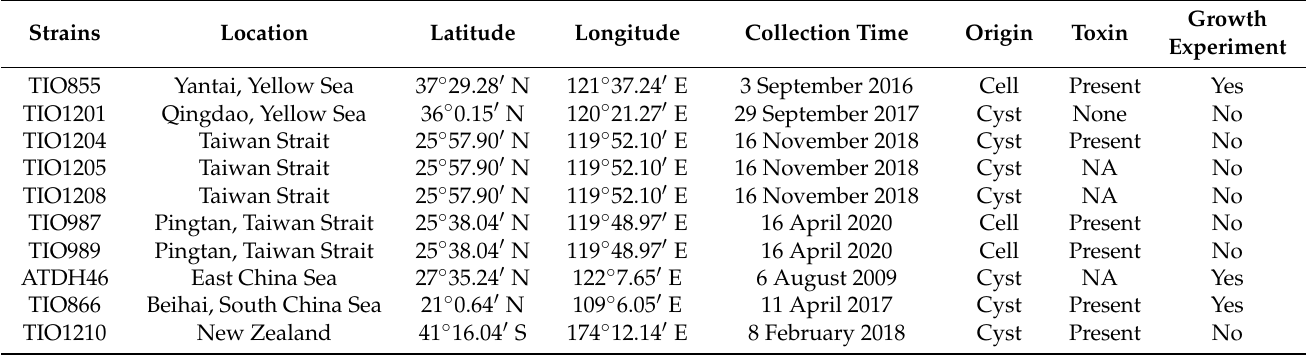
Table 1. Information of strains examined in this study, including location, latitude, longitude, collection time, origin, toxin, and growth. NA: not